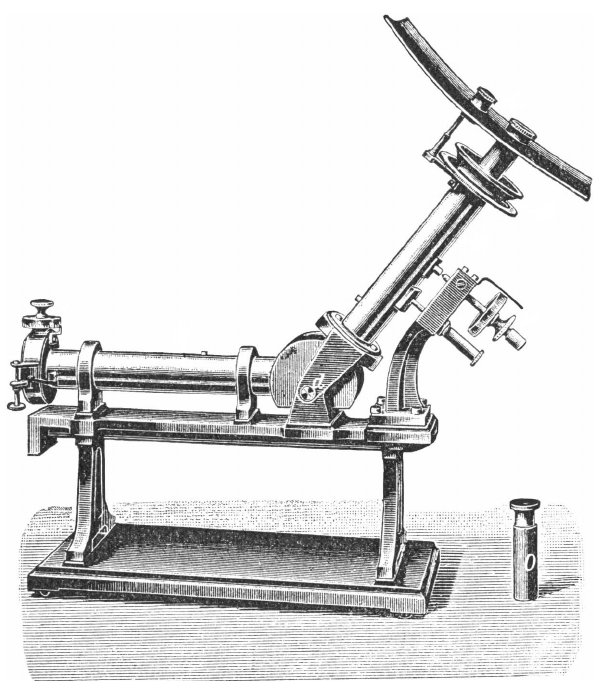
Figure 7. A popular spectrophotometer invented by A. König and improved by F. F. Martens in 1903. The instrument contains two Ice- land spar prisms and a glass dispersing prism. From Weigert (1927); a light source and sample platform to the left are not shown.